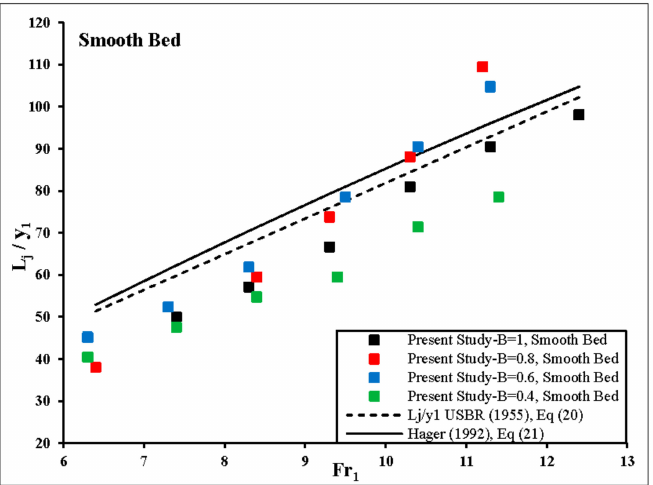
Figure 12. Variation of the relative length of the hydraulic jump ( L j / y 1 ) vs. the inflow Froude number with different divergence ratio on a smooth